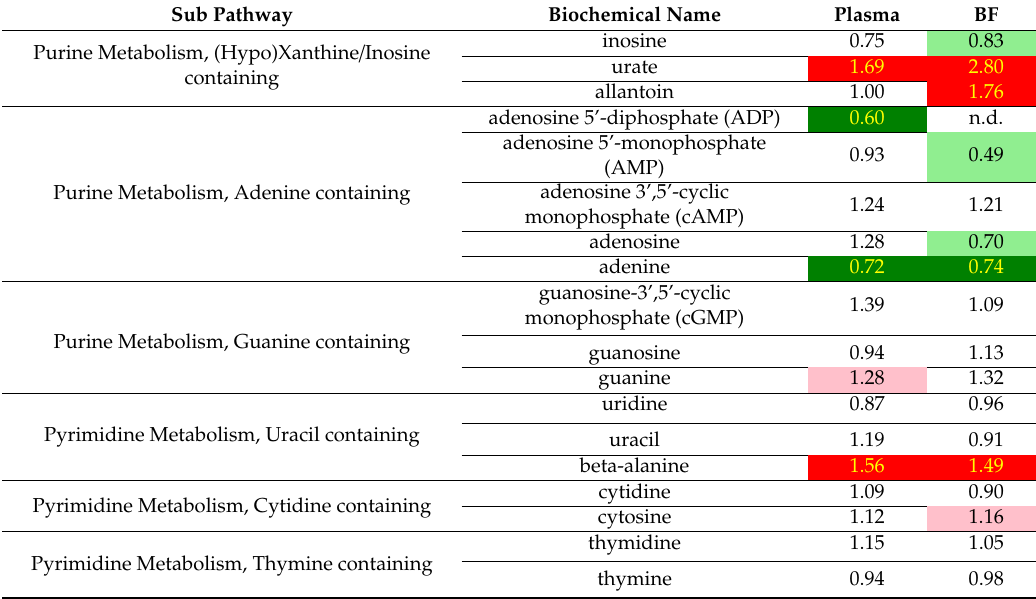
Table 5. List of selected nucleotides that were detected in maternal plasma and blastocysts cavity fluid (BF) in non-diabetic and diabetic